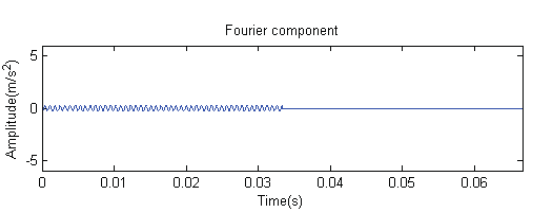
Figure 11. Fourier component.